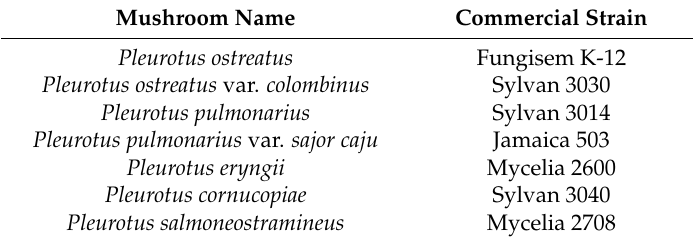
Table 3. The names of the species and strains of the different mushrooms used in the present study. Mushroom